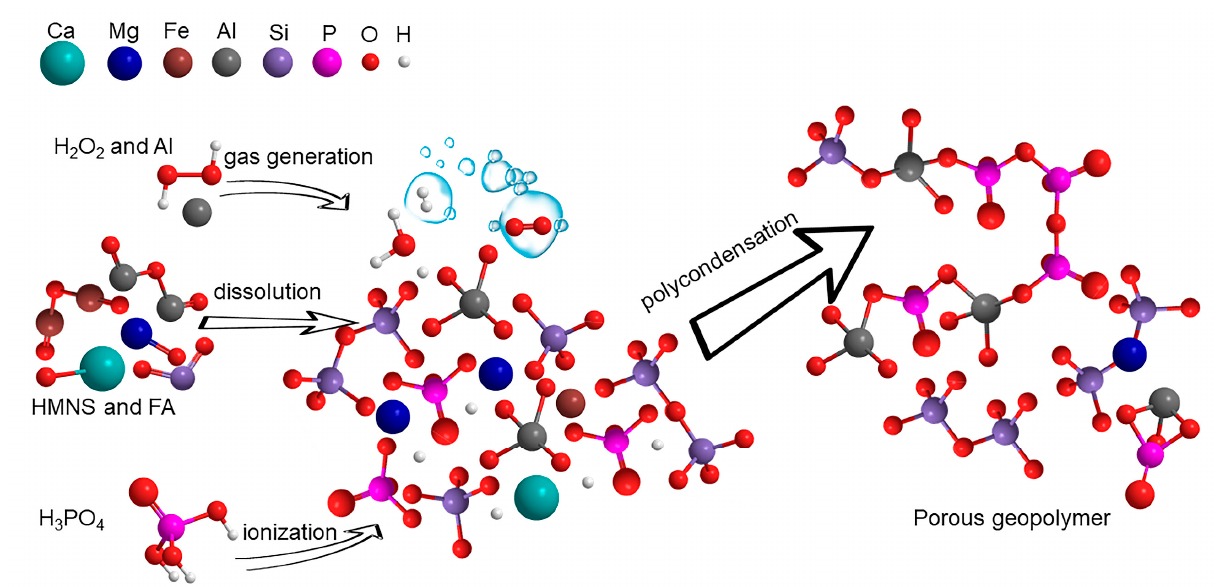
Figure 14. Geopolymerization reaction process of porous